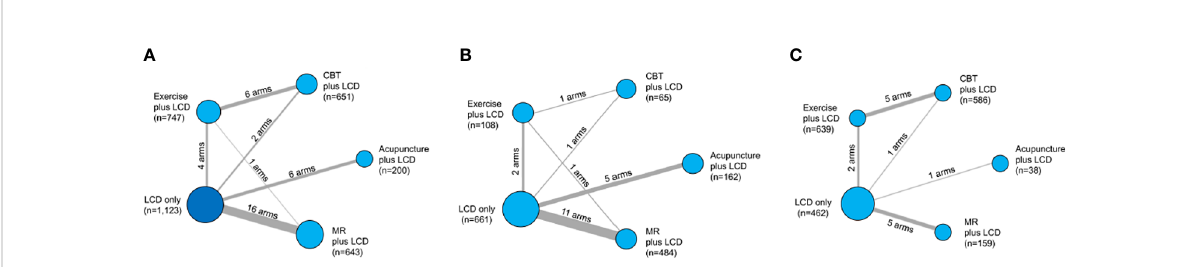
FIGURE 2 Network geometry of the fi ve lumped interventions. Network geometry of the all study arms (A) , short-term ( ≤ 12 weeks) study arms (B) , and long- term (>12 weeks) study arms (C) . LCD, low-calorie diet; CBT, cognitive behavioral therapy; MR, meal replacement. The nodes correspond to the intervention type, and the edges correspond to the intervention arm between the two interventions. The size of the nodes indicates the number of patients, whereas the thickness of the edges indicates the number of intervention